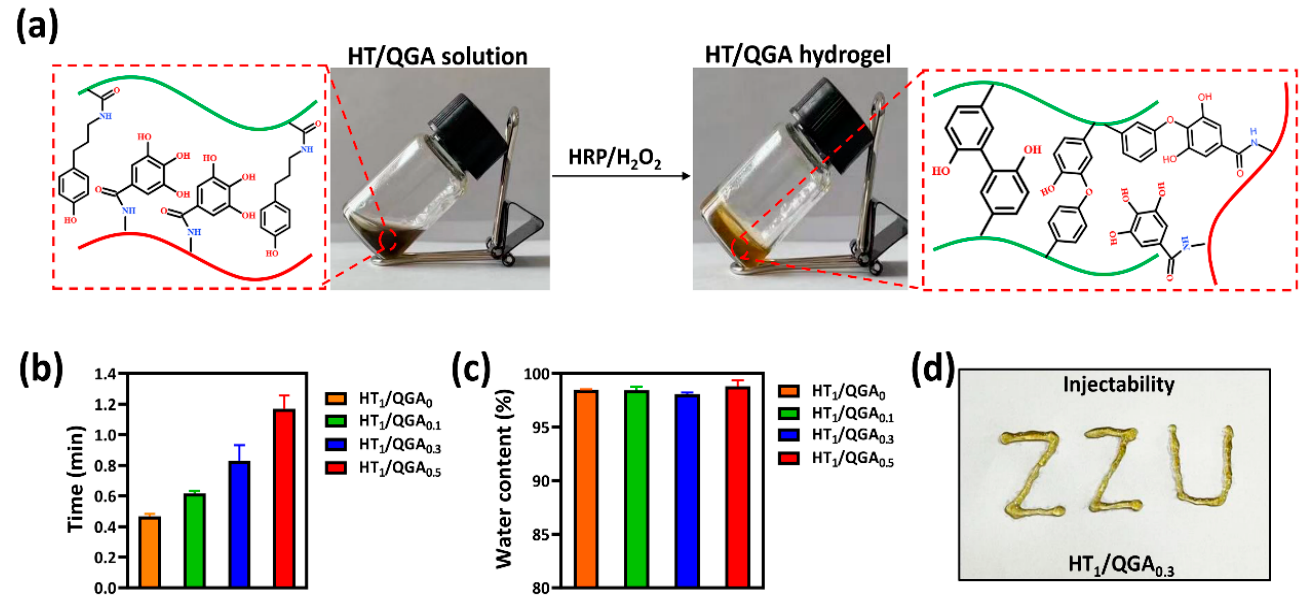
Figure 2. ( a ) Scheme of the HT/QGA hydrogel cross-linked by HRP and H 2 O 2 . ( b ) Gelation time, ( c ) water content and ( d ) injectability of HT/QGA hydrogel. Mean ± SD, n = 3.